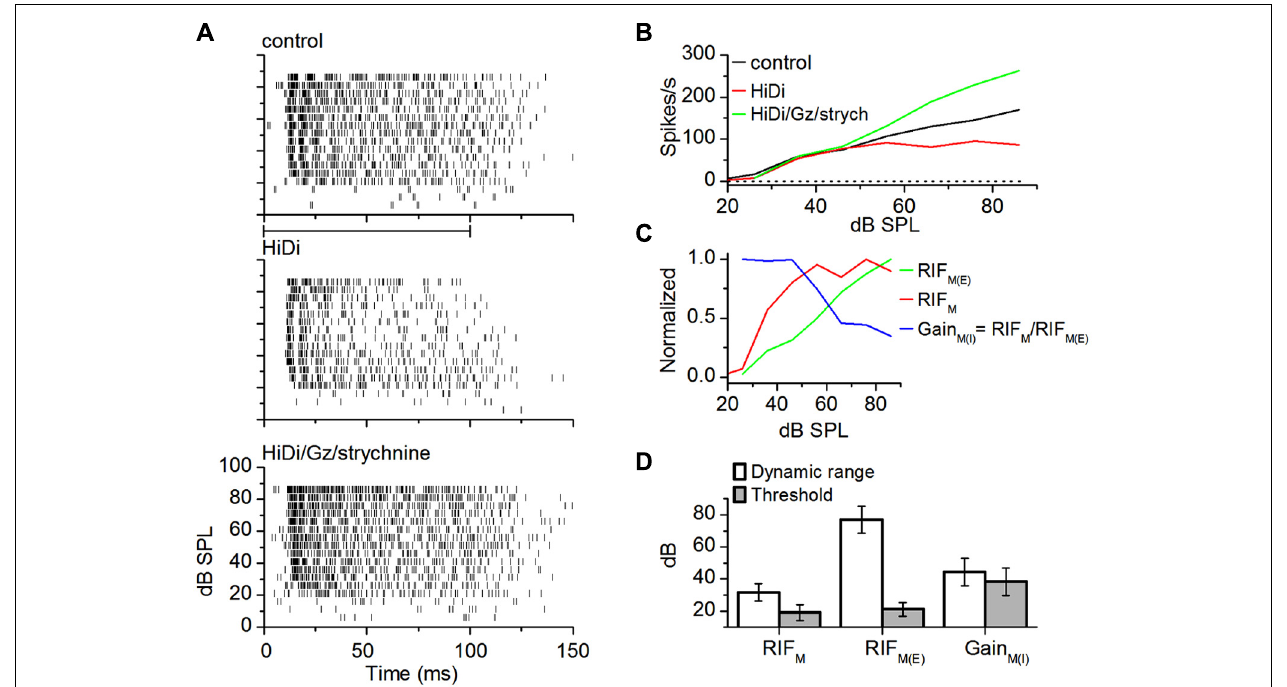
net monosynaptic input, RIF M , which saturates. (C) RIF M consists of an excitatory component, RIF M ( E ) , and an inhibitory monosynaptic component which exerts a gain, Gain M ( I ) = RIF M /RIF M ( E ) . Push–pull interaction between monosynaptic inhibition and excitation generates the net monosynaptic input. RIF M ( E ) /RIF M slope ratios: rising limb, 2.12 ± 0.085; falling limb, 2.24 ± 0.13; (D) average threshold and dynamic range. 16 cells. Mean and